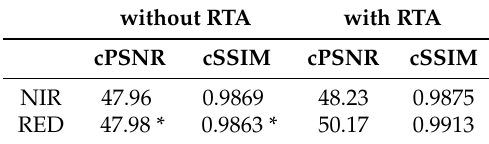
Table 2. RAMS results with and without RTA (residual temporal attention) branch. Values for RED without RTA, highlighted with the asterisks, are computed with the last valuable parameters before training